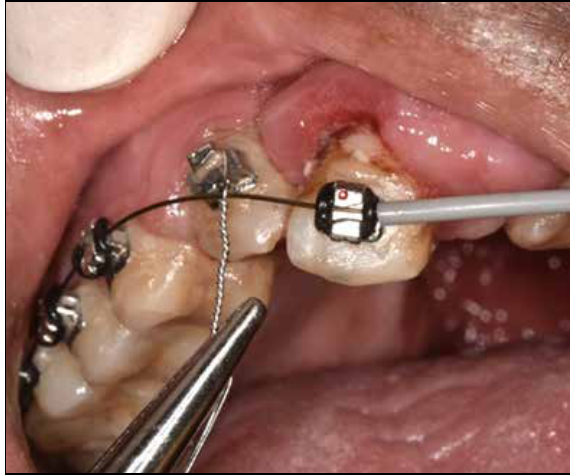
Figure 4. Place small diameter arch wire in either steel or NiTi after light curing each bracket for a minimum of 60